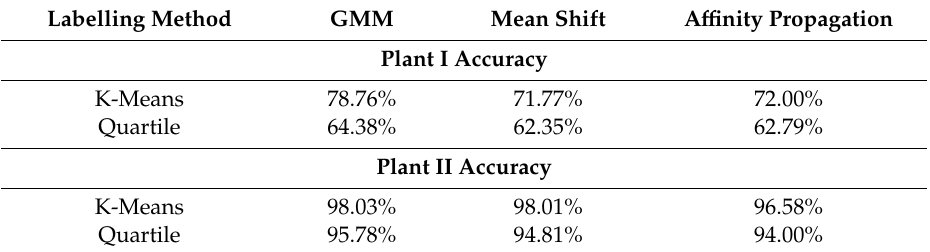
Table 4. Accuracy results of the DT 2 -SVM-KC algorithm for both plants.